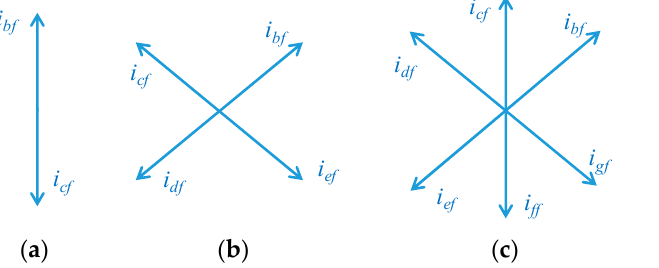
Figure 12. New current references with one-phase open-circuited ( a ) three-phase; ( b ) five-phase; ( c ) seven-phase.